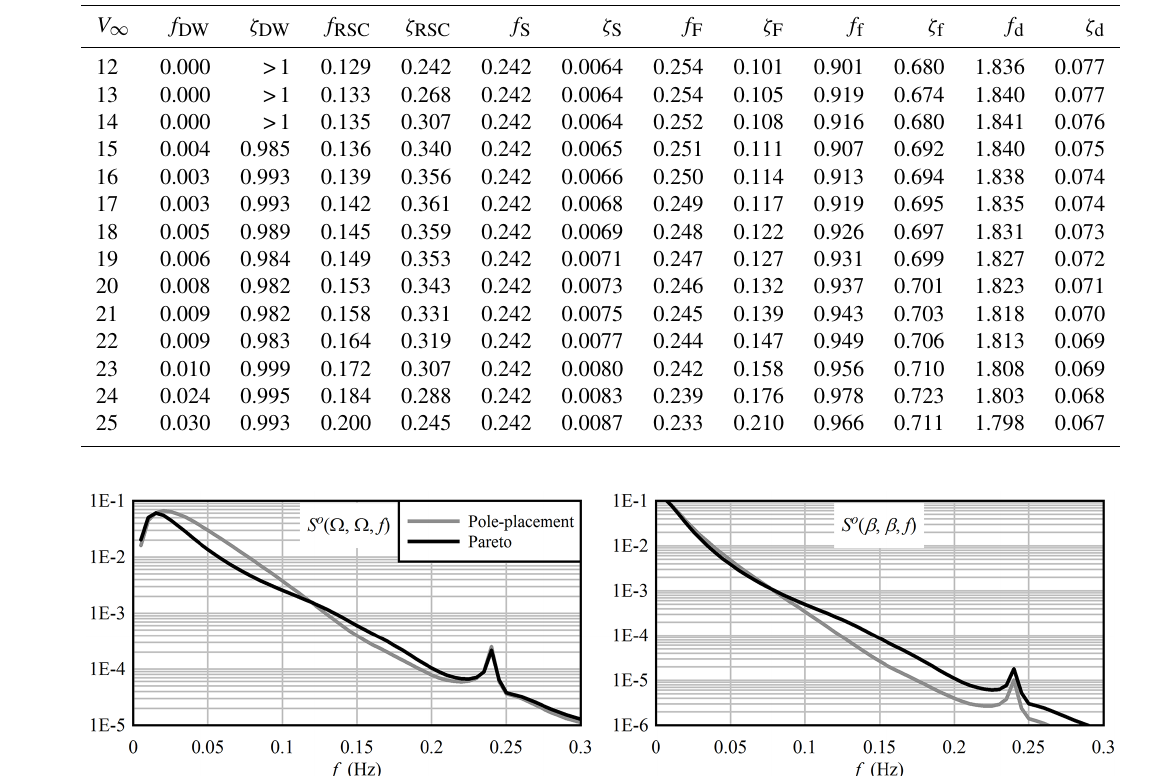
Figure 19. An example of how tighter speed control is obtained by increasing the frequency of the rotor speed control mode. The wind